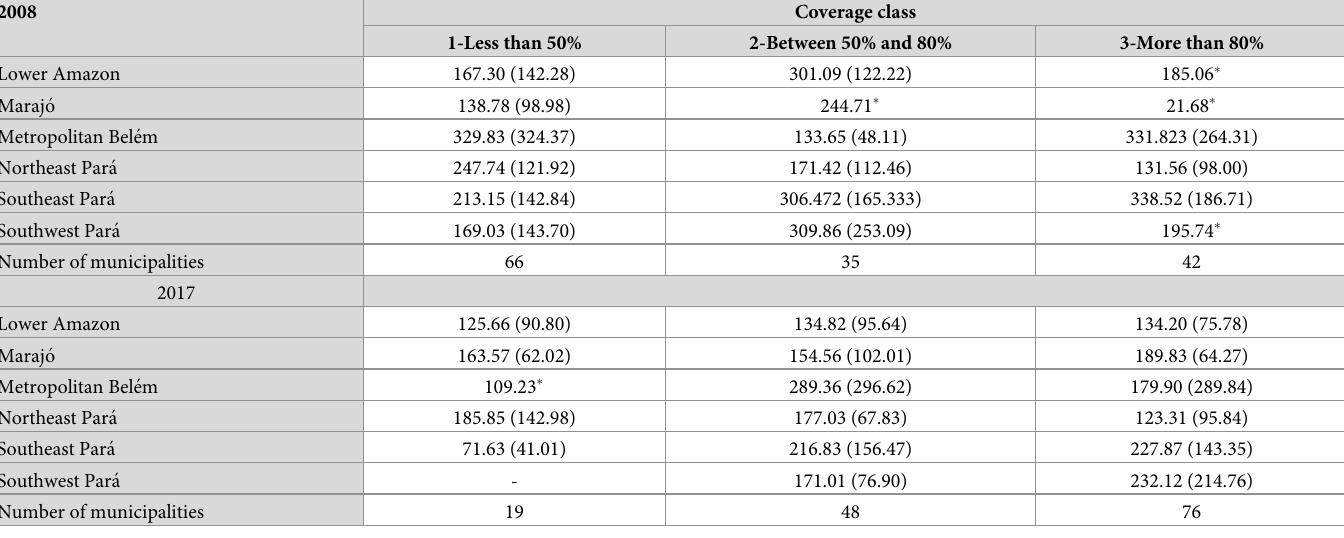
Table 1. Rate of ACSH by primary care population coverage class and mesoregions of the state of Para´, 2008–2017.